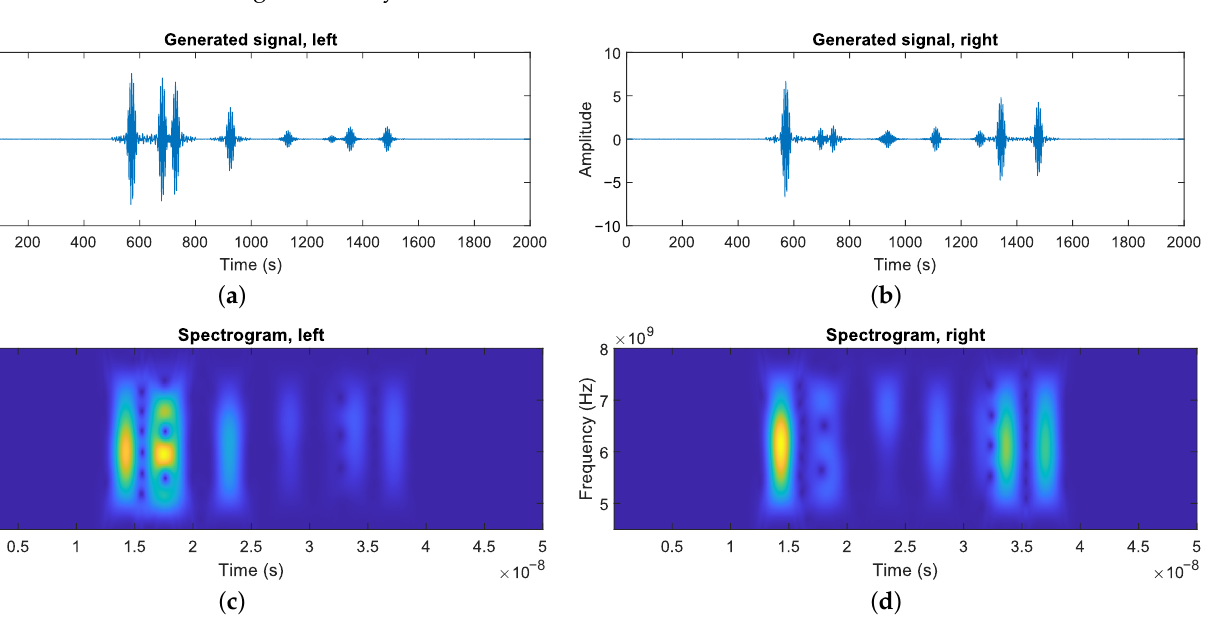
Figure 5. A complete measurement produced by the simulator. ( a , b ) The waveform measurements using the simulated radar sensor in a virtual environment for the left and right channel. The initial pulse is omitted for improved visibility. ( c , d ) The spectrogram representation of the